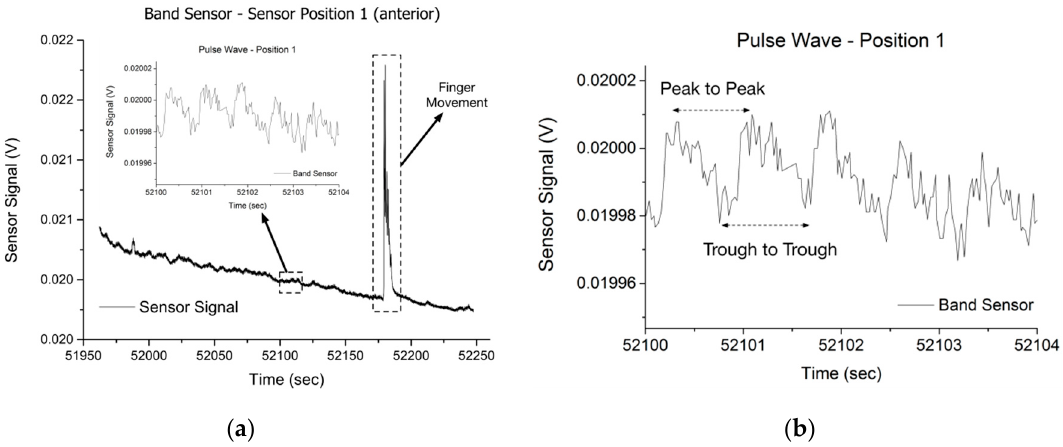
Figure 15. Raw data from the Position 1 test is displayed ( a ), detailing the difference between the stable signal and when the fingers are flexed. The stable area ( b ) was used for pulse wave analysis.